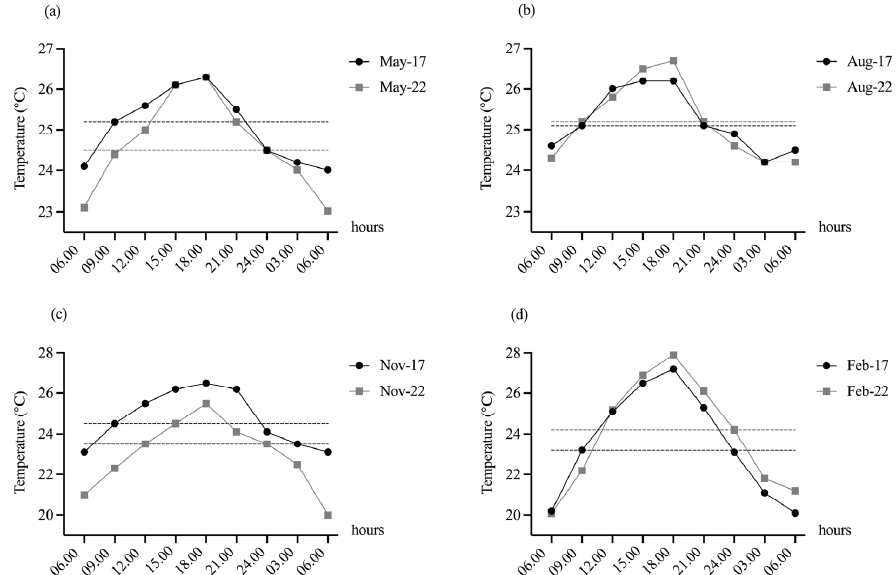
Figure 4. The diurnal variations of WT at Pakkok River during the study periods of wet season; May ( a ), August ( b ) and dry season; November ( c ), February ( d ) in 2017 and 2022. The average WT in Pakkok River was monitored on the 15th and 28th of each observed month (May, August, November, and February) during 2017 and 2022. The data presented at the predetermined time intervals of 3.00, 6.00, 9.00, 12.00, 15.00, 18.00, 21.00, and 24.00 h were the average values of the 15th (n = 3) and 28th (n = 3) of the month. Dash lines in black and light grey represent the daily median WT on each month of year 2017 and 2022, respectively.